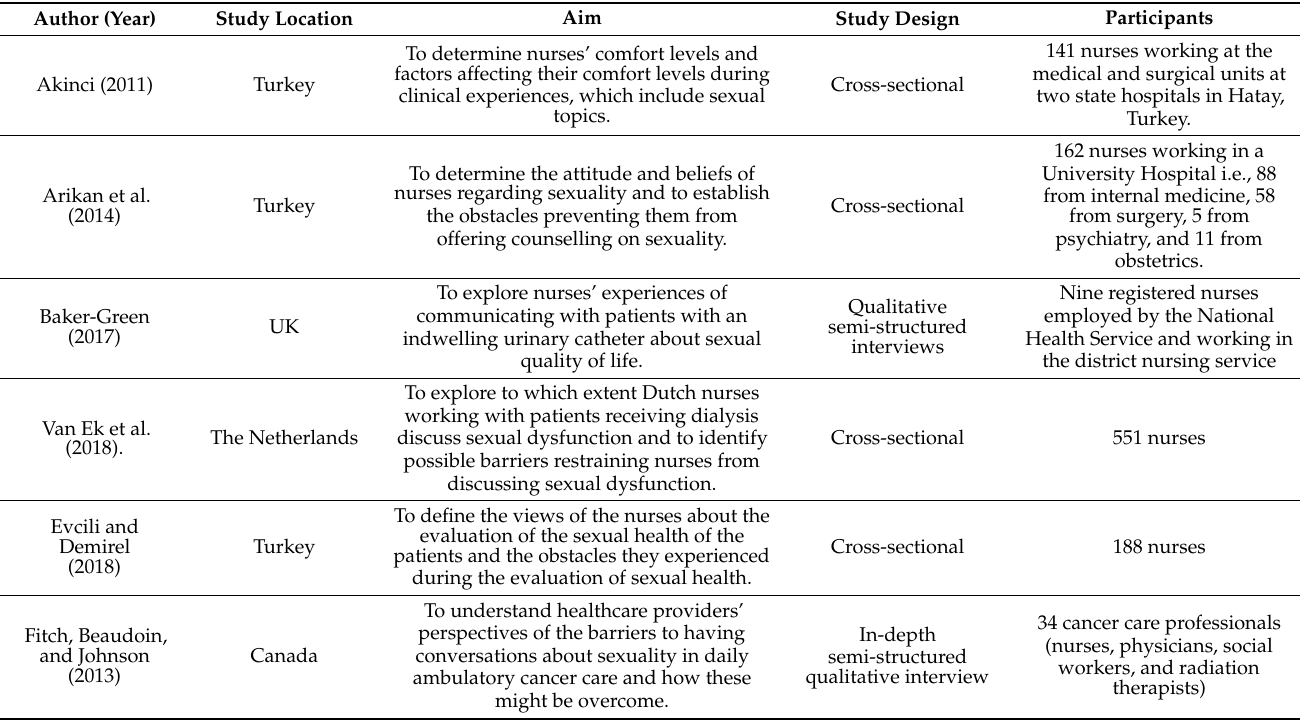
Table 3. Summary of the studies included in the